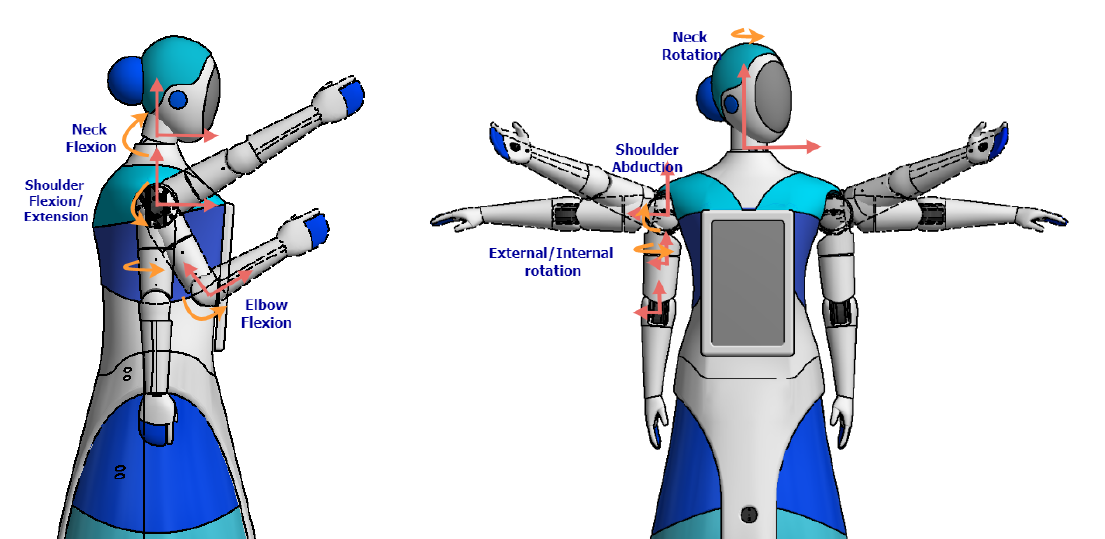
Figure 7. Movement of arms and head of the